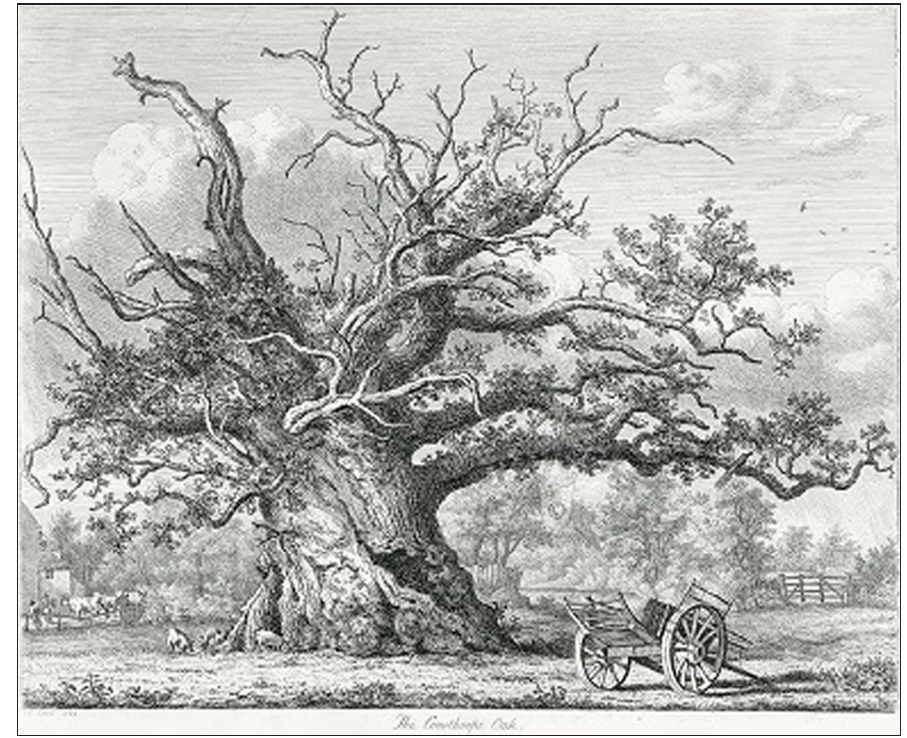
Fig. 1 : Jacob George Strutt, The Cowthorpe Oak , 1826, etching, from Sylva Britannica (London: Strutt and Colnaghi,